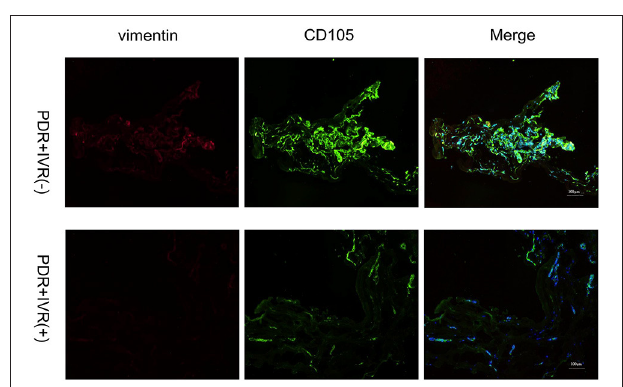
FIGURE 3 | Epiretinal fibrovascular membranes (FVMs) showed strong positive for EPO and the marker CD105 of neovascular endothelial cells in the Non-IVR group. Scale bars: 100 µ m.